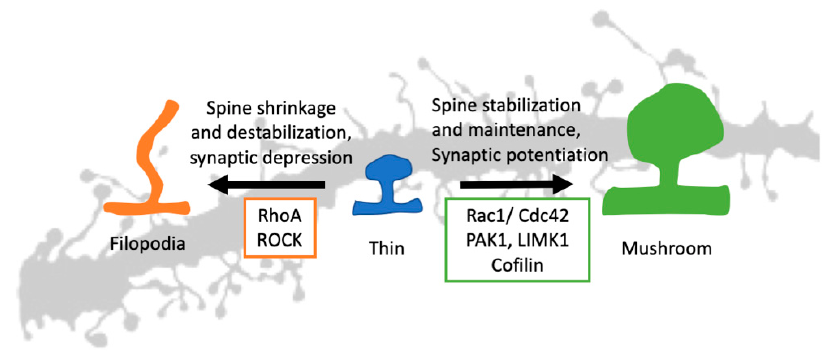
Figure 3. Rho GTPases in spine morphogenesis. A thin, immature spine can stabilize using synaptic potentiation and Rac1/Cdc42 signaling. Using the downstream signaling and actin effectors, both Rac1 and Cdc42 can stabilize an immature spine resulting in a mature mushroom-shaped spine. The RhoA and synaptic depression do the opposite. The RhoA signaling pathway, along with ROCK, can destabilize the spine and give it a filopodia shape. (Rac1: Ras-related C3 botulinum toxin substrate 1, Cdc42: Cell division control protein 42 homolog, RhoA: Ras homolog gene family, member A, PAK1: p21-activated kinase 1, LIMK1: LIM domain kinase 1, ROCK: Rho-associated, coiled-coil-containing protein kinase). Actin can remain in either monomeric G (globular) state or polymeric F (filamentous)